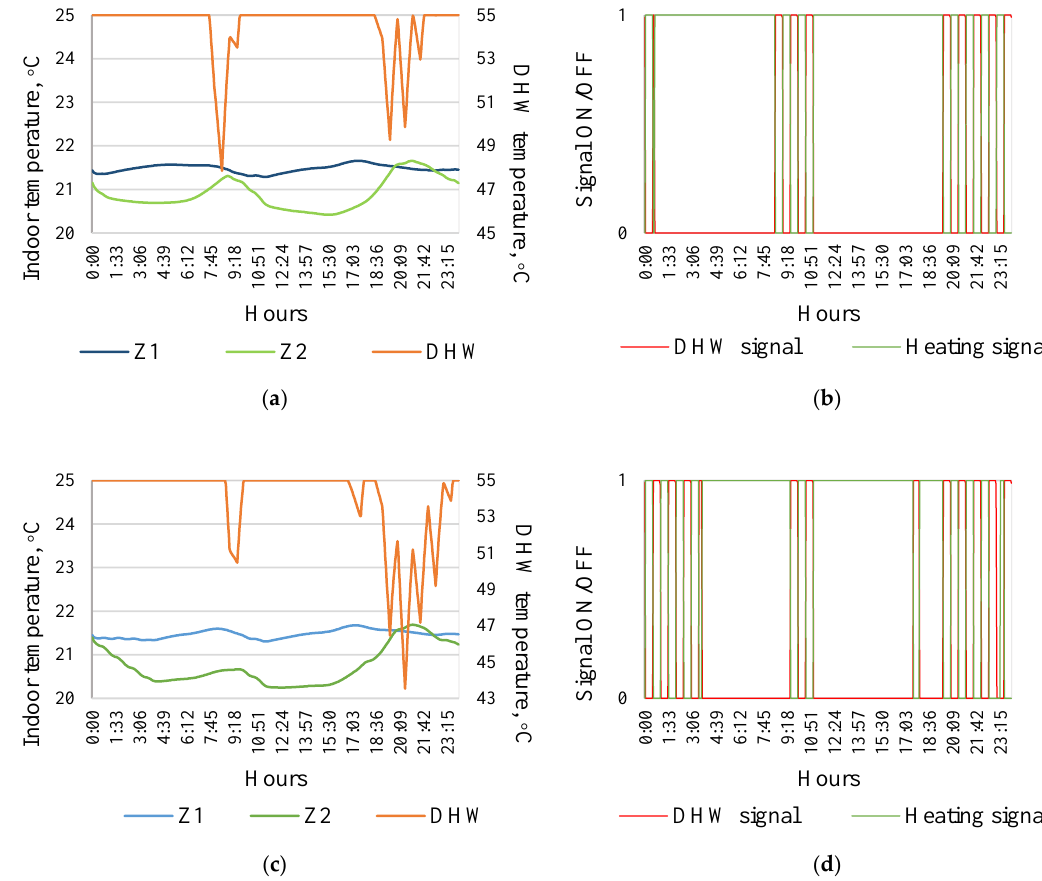
Figure 12. Internal gains are considered ( a ) Indoor temperature and DHW supply temperature for a single-family house occupied by four people, ( b ) heating and DHW signals for a single-family house occupied by four people, ( c ) indoor temperature and DHW supply temperature for a single-family house occupied by six people, ( d ) heating and DHW signals a single-family house occupied by six people.